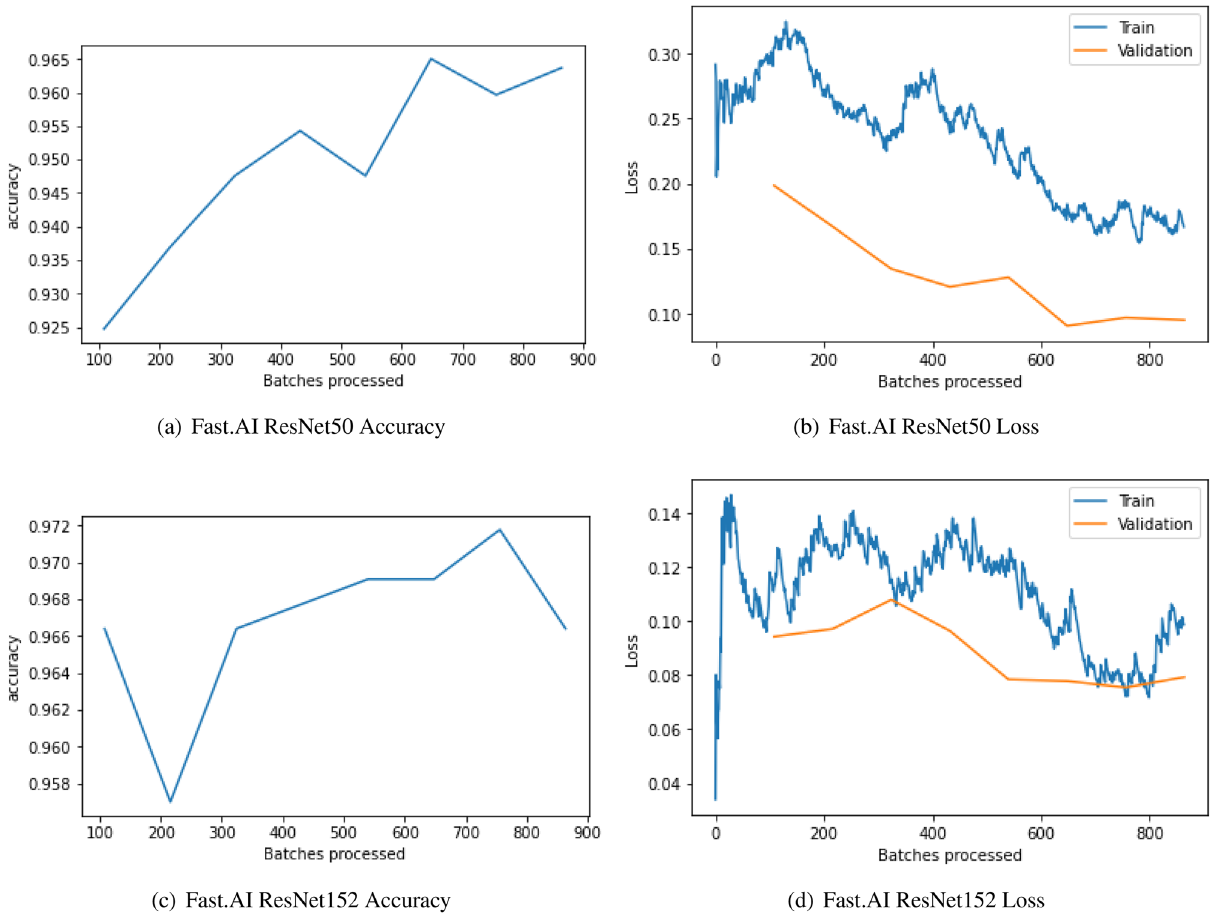
Figure 11. Model Fast.AI ResNet50 and Fast.AI ResNet152 for COVID/non-COVID on CT-scan